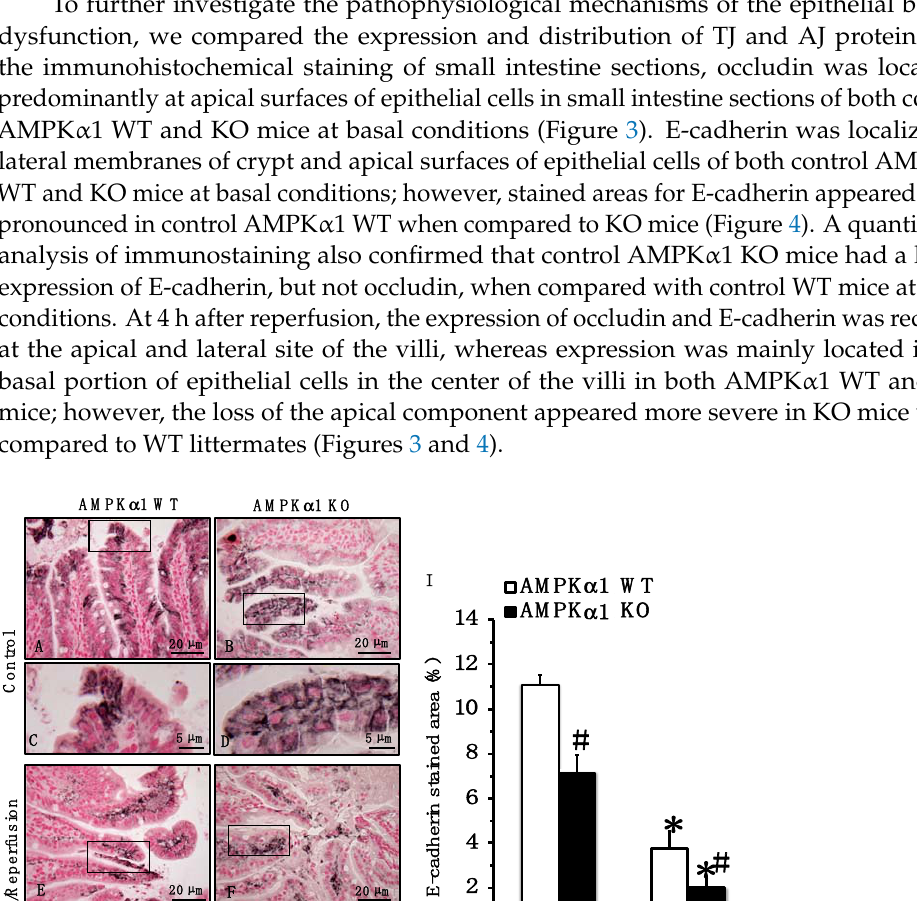
Figure 4. Effect of genetic deficiency of AMPK α 1 on gut localization of occludin. ( A – H ) Representa- tive photomicrographs of immunostaining of occludin in ileum sections. Black boxes in ( A,B,E,F ) indicate regions of magnified insets shown in ( C,D,G,H ). In control AMPK α 1 WT ( A , C ) and KO mice ( B , D ), occludin was mainly found on the epithelial membrane surface. At 4 h after mesenteric